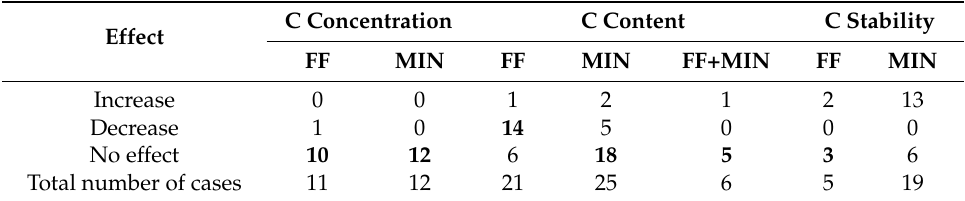
Bold highlights the main effect in each column. Data extracted from 23